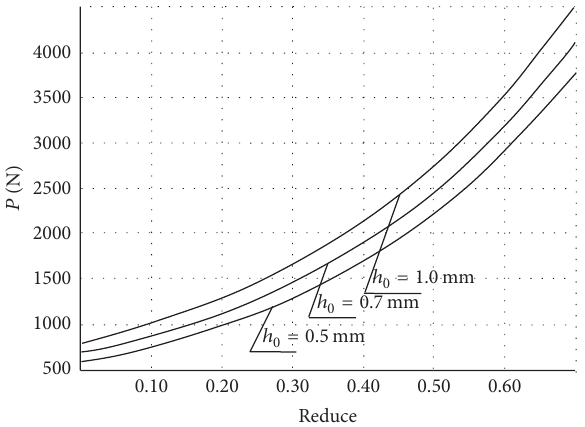
Figure 11: The results of automated design of the efforts on the roller electrode, depending on reduce. 𝑅1 = 50 mm; 𝑎 1 = 0.124 ; 𝑎 2 = = −3.70 ; 𝜎 = 60.1 N/mm 2 ; 𝜆 = 0.26 . 0.052 ; 𝑎 3 𝜏0 with reduce of 0.15 ⋅ ⋅ ⋅ 0.30 because of increasing of the energy intensity of the process.